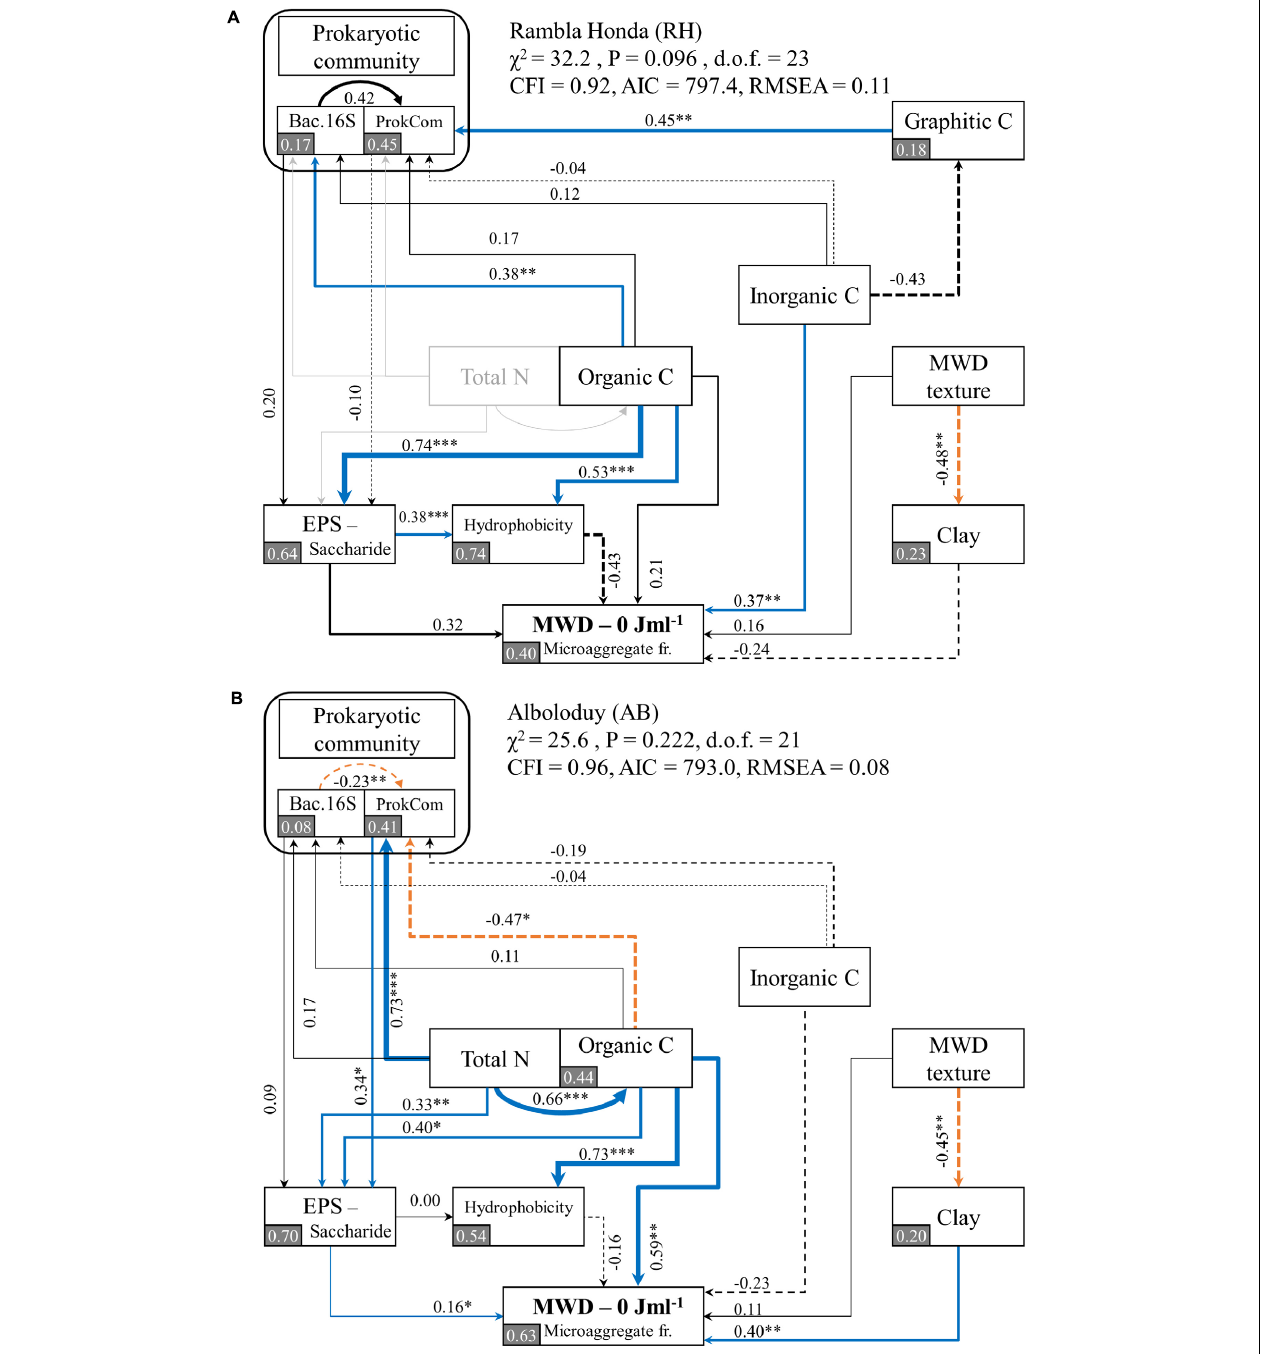
FIGURE 6 | Results from structural equation modeling (SEM), showing the direct and indirect effects of the prokaryotic community and environmental parameters on microaggregation, expressed as the mean weight diameter (MWD) without sonication, for Rambla Honda (A) and Alboloduy (B) sites. As explained in section “Data Analysis and Statistics,” the SEM for Rambla Honda (A) had to be modified to obtain a significant result, whereby the total N was excluded (indicated in light gray). Note that Bac16S stands for the bacterial abundance as measured by bacterial 16S rRNA gene copy numbers ( Supplementary Figure S4A ) and ProkCom stands for the prokaryotic community composition similarity as derived from the first PCoA axis ( Supplementary Figure S7 ). The width of the arrows is proportional to the strength of path coefficients. An orange dashed arrow indicates a negative significant effect, blue arrows a positive significant effect and a solid or dashed black arrow indicate a non-significant positive or negative effect, respectively. Additionally, the numbers indicate the standardized path coefficients, analogous to relative regression weights, and indicative of the effect size of the relationship. Significance levels for the effects are as follows: * p < 0.05, ** p < 0.01, and *** p < 0.001. In gray squares, the proportion of variance (R 2 ) of the variable as explained by the model, is displayed. Model statistics are given in the figure with degrees of freedom (d.o.f.), comparative fit index (CFI), akaike information criterion (AIC) and root mean square error of approximation